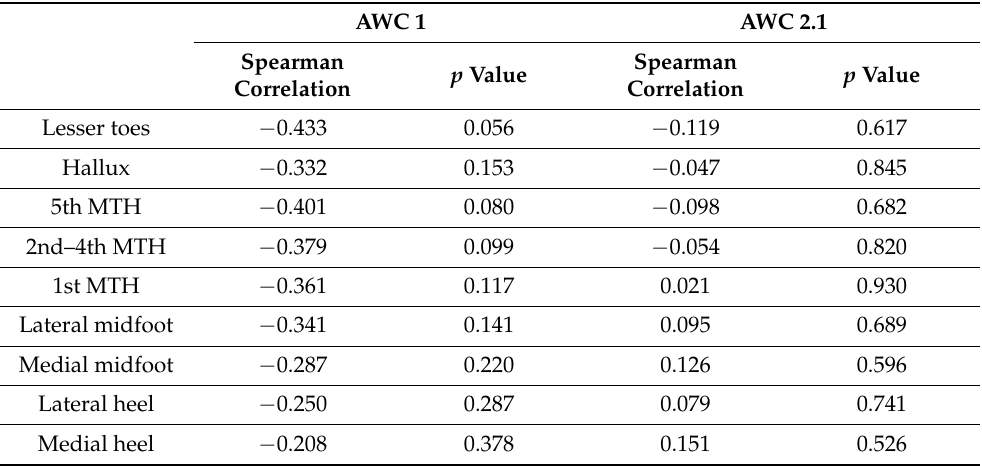
Table 6. Correlations between the perceived comfort of the sock models and the temperature values of the areas of